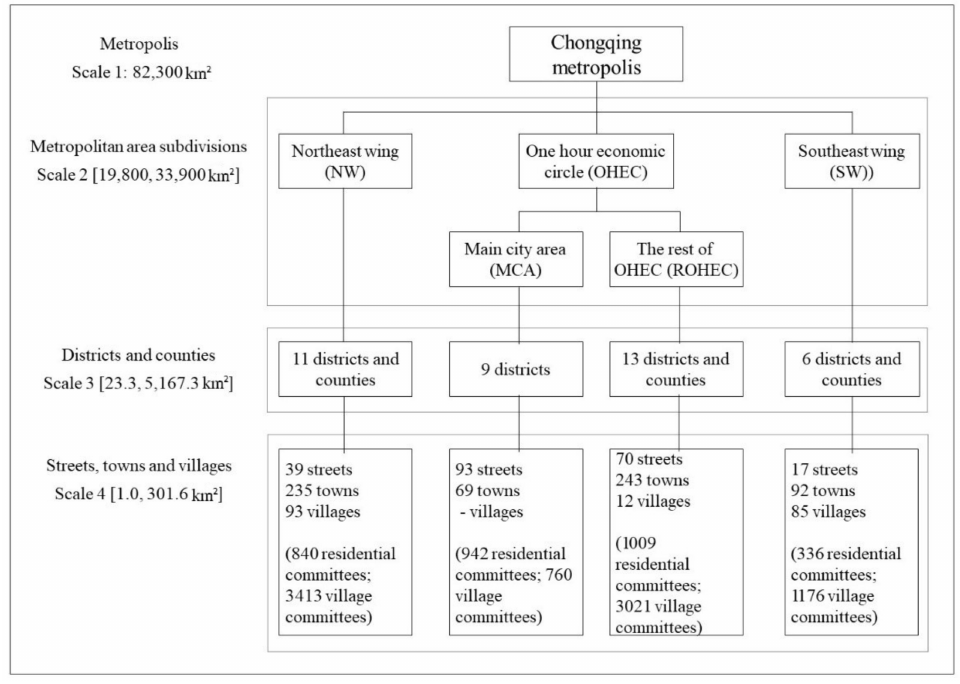
Figure 2. The multiscale administration framework of Chongqing. Source: edited by the authors.